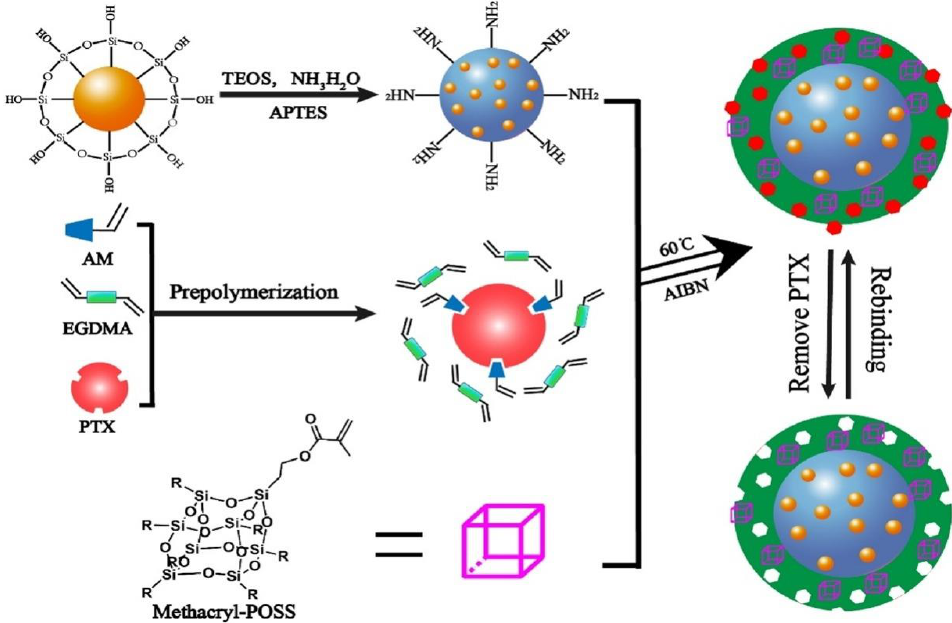
Figure 13. Schematic illustration for the preparation process and possible detection principle of the POSS-MIP/QDs. Adapted from ref. [109], copyright 2021, with permission from Elsevier. Van Tam et al. [107] used microwave-assisted pyrolysis of fructose to synthesize ani- line-functionalized graphene quantum dots (a-GQDs). Then, phenyl boric acid (PBA) was used to modify the a-GQDs, leading to a fluorescence-quenching effect. The a-GQDs/PBA nanomaterial was tested as a fluorescence turn-on sensor for glucose detection, based on the specific interaction between PBA and glucose.